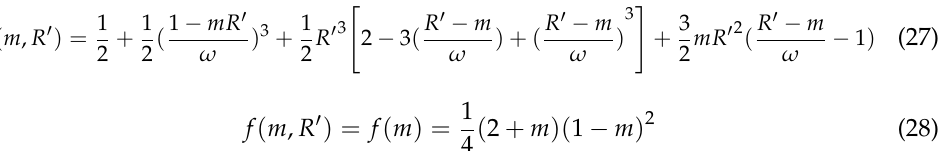
Figure 3. Effect of contact angle on nucleation. (2) Effect of roughness on ice nucleation Traditionally, the microscopic shape of the nucleating matrix surface has not been considered in the process of nucleation. However, the surface roughness of the nucleating matrix could be another major factor affecting ice nucleation besides the contact angle. Compared with the nucleating substrate surface, the size of the crystal nucleus is negligi- ble. For the crystal nucleus, there is a certain roughness on the smooth wall surface. There- fore, the influence of roughness on ice crystal nucleation should be considered. The z- expression of the influence factor of roughness is shown in Equation (29). para AA Z = (29) In the formula, A ra represents the actual surface area, and A pa represents the projected area of the surface. After introducing the roughness factor, the relationship between the contact angle and surface roughness can be expressed as: